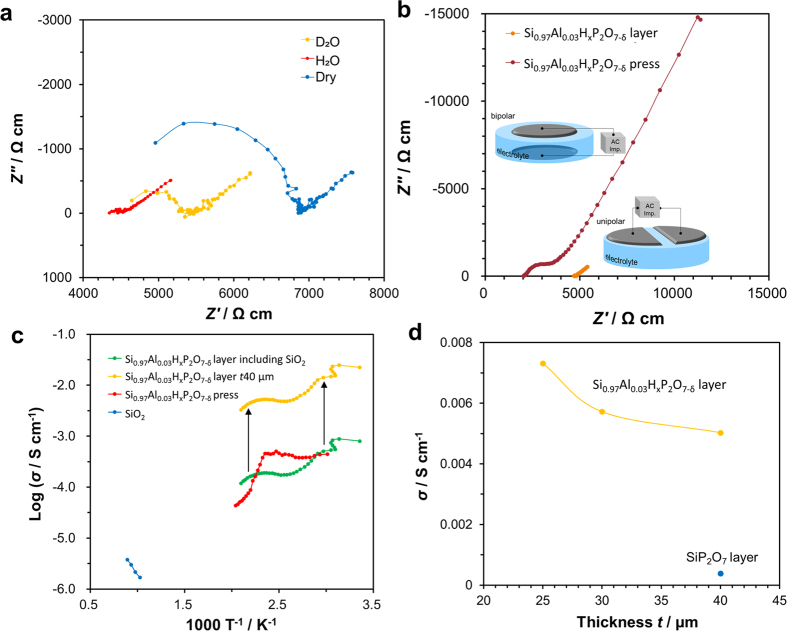
Electrochemical properties of Si0.97Al0.03HxP2O7-δ layer and pressed pellet at 150 °C.(a) Impedance spectra of Si0.97Al0.03HxP2O7-δ/Si0.97Al0.03O2-δ composite disk under non-humidified and humidified conditions, (b) impedance spectra of Si0.97Al0.03HxP2O7-δ/Si0.97Al0.03O2-δ composite measured in unipolar mode and Si0.97Al0.03HxP2O7-δ pressed pellet measured in bipolar mode, (c) electrical conductivities of Si0.97Al0.03HxP2O7-δ/Si0.97Al0.03O2-δ composite and pressed pellet, Si0.97Al0.03HxP2O7-δ layer, and Si0.97Al0.03O2-δ substrate, and (d) electrical conductivity of Si0.97Al0.03HxP2O7-δ layer as a function of thickness. For comparison, data for a 40-μm-thick SiP2O7 layer are also included.